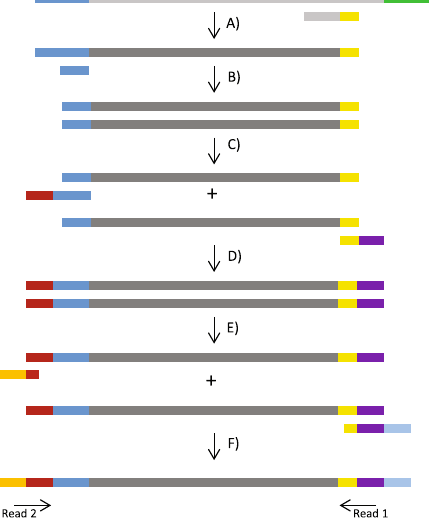
Figure 1. Graphical summary of the SL-seq protocol. (A) cDNA generation with Superscript III and a primer that is partially random (7 nucleotides, grey), and partially fixed (yellow). Consequent degradation of the RNA strand with RNAse H, leaving a single stranded DNA molecule. (B) Second strand synthesis of SL-containing DNA molecules with Klenow fragment and a primer that is complementary with the SL (dark blue). (C + D) PCR for amplification and addition of adapter motives (red and purple) making the library compatible with the Nextera XT index kit (Illumina). (E + F) Final PCR adapter extension, indexing (orange and light blue) and amplification of the library fragments with the primers of the Nextera XT index kit. Dark Blue: SL/ complementary with SL, light grey: RNA, dark grey: DNA, green: poly-A tail. Other colors: primer and adapters